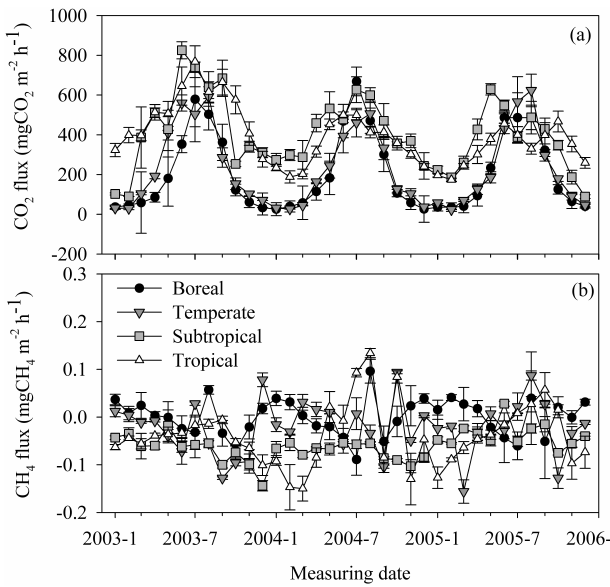
Fig. 4. Seasonal patterns of CO 2 and CH 4 fluxes ( ± 1SE) mea- sured in the four